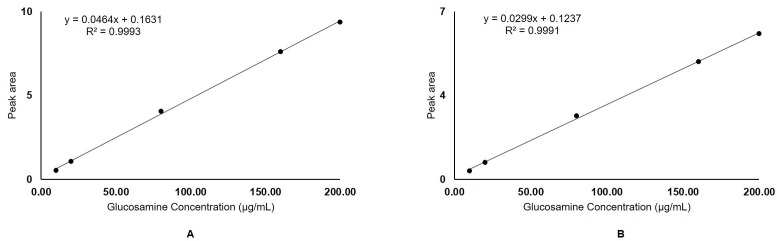
Calibration curve with linear regression equations and correlation coefficients (r2) generated by plotting peak areas versus glucosamine concentrations (10–200 μg/mL) of A) Glucosamine hydrochloride reference standard; B) Glucosamine sulphate reference standard.